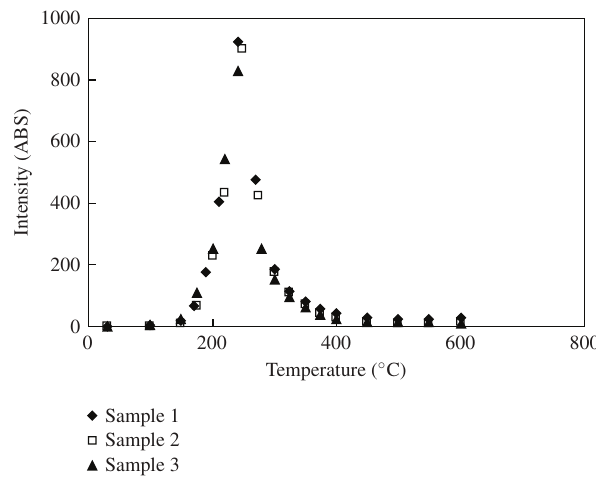
FIGURE 2: Hg emission from coal with the increased temperature in furnace.